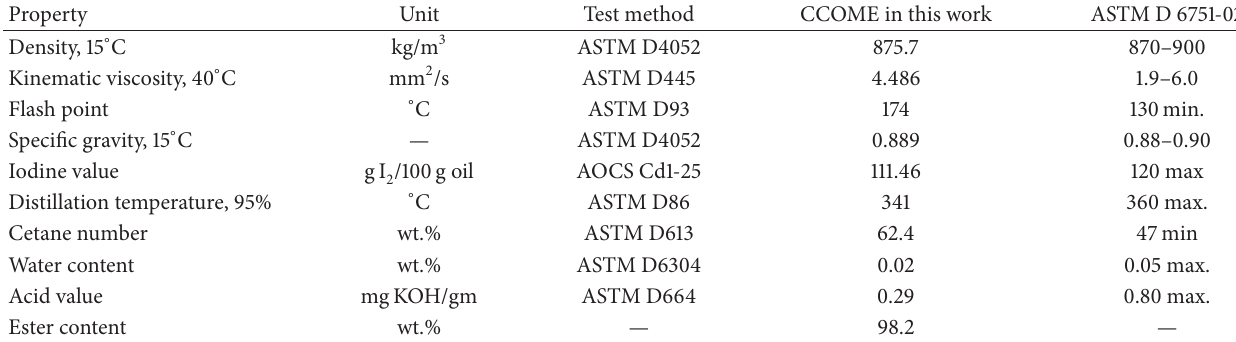
Table 3: Fuel parameters of CCOME as compared to ASTM standards.